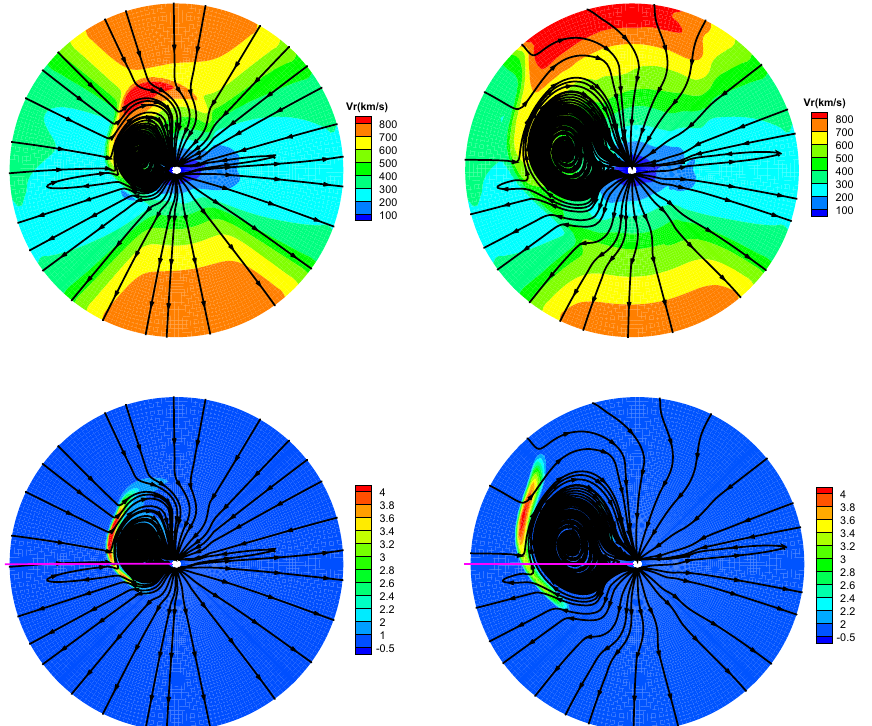
Fig. 6. Time evolution of the CME in the x – z meridional plane at 3 h (left), 6 h (right). Solid black lines display the projection of the magnetic fi eld lines, the false color images in the top row are velocity and in the bottom row are relative density.